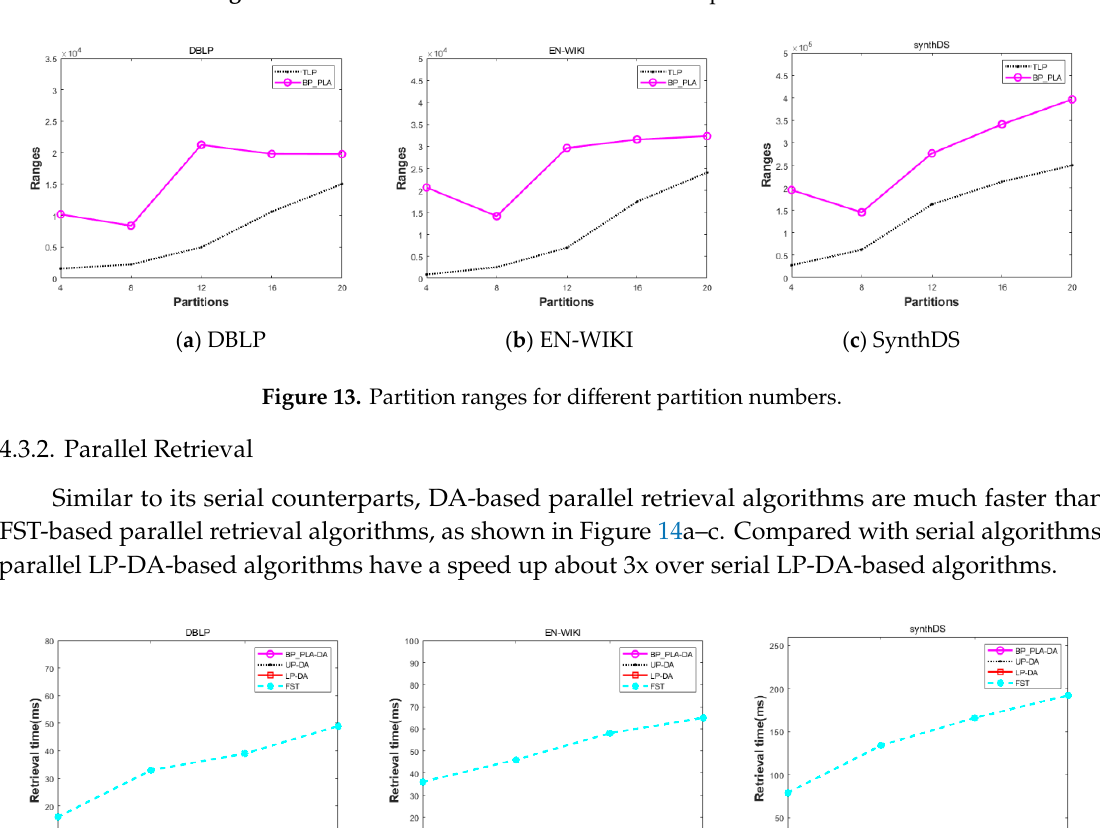
Figure 12. Parallel construction times for different partition numbers.